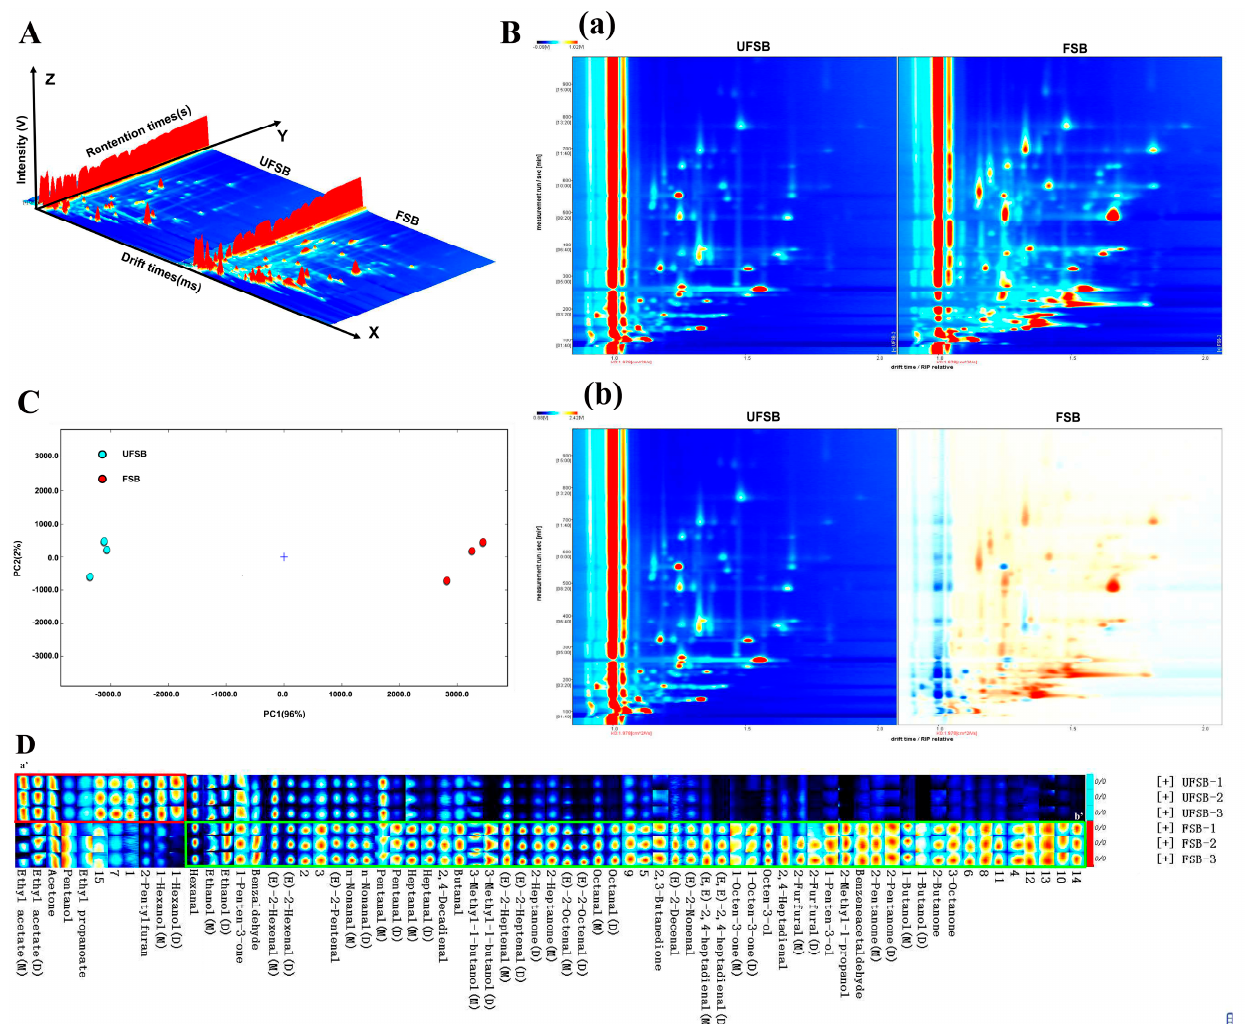
Figure 2. The volatile organic compounds analysis in soy beverage by HS-GC-IMS. ( A ) 3D- topographic features of samples, ( B ) 2D-topographic top view plot of samples ( a ): normal top view plot, ( b ): 2D-topographic top view plot deduction), ( C ) PCA score of samples, and ( D ) fingerprint spectra of